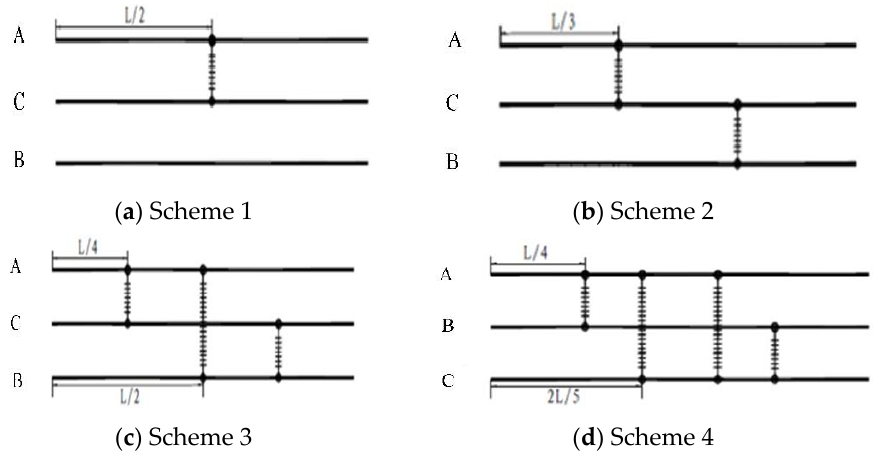
Figure 9. Diagram of the arrangement schemes of interphase spacers.